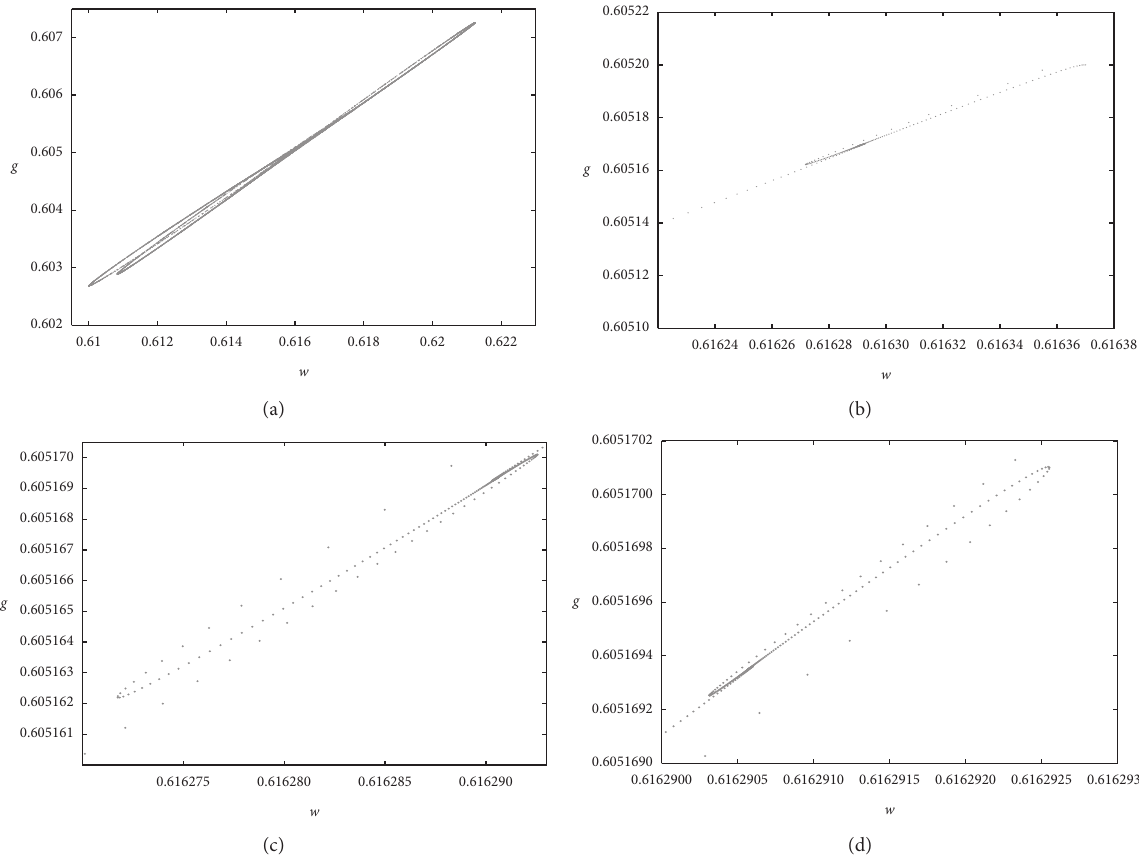
Figure 4: (a) Phase portraits for a � 248 . 97819 and b � 15 . 1575. (b) Phase portraits for a � 248 . 97816 and b � 15 . 157509. (c)-(d) Local amplifications corresponding to